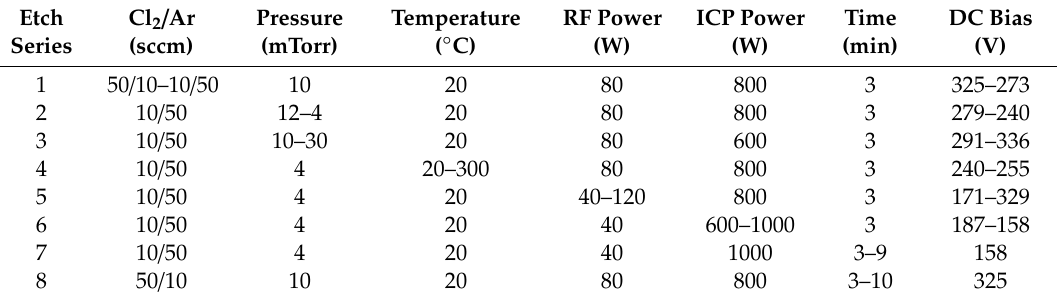
Figure 1. ( a ) Sketch of the process flow for fabrication of gallium nitride (GaN) nanorods. Plan view and cross-sectional (inset) scanning electron microscopy (SEM) image of nickel mask on ( b ) ( 112̅2 ) semi-polar and ( c ) ( 112̅0 ) non-polar GaN layers. Table 1. Dry etching conditions employed in the various “etch series”.